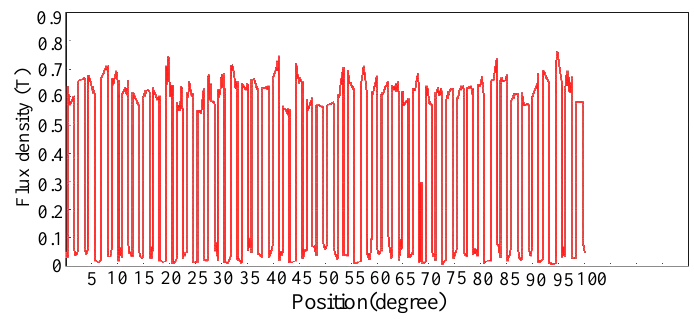
Figure 5. Magnetic flux density distribution of the rotor. ( a ) 3D magnetic flux density distribution of the rotor. ( b ) Magnetic flux density distribution of the rotor cross section. Figure 6 shows the flux density distribution in the air gap; the magnetic density reached the maximum value when the teeth of stator and the teeth of the rotor were aligned. The peak value of the air-gap flux density exhibited appropriate value, with nearly 0.6 T to 0.7 T. Figure 7 shows the flux density distribution of the tooth. It can be seen that the magnetic field distribution of the motor is reasonable.